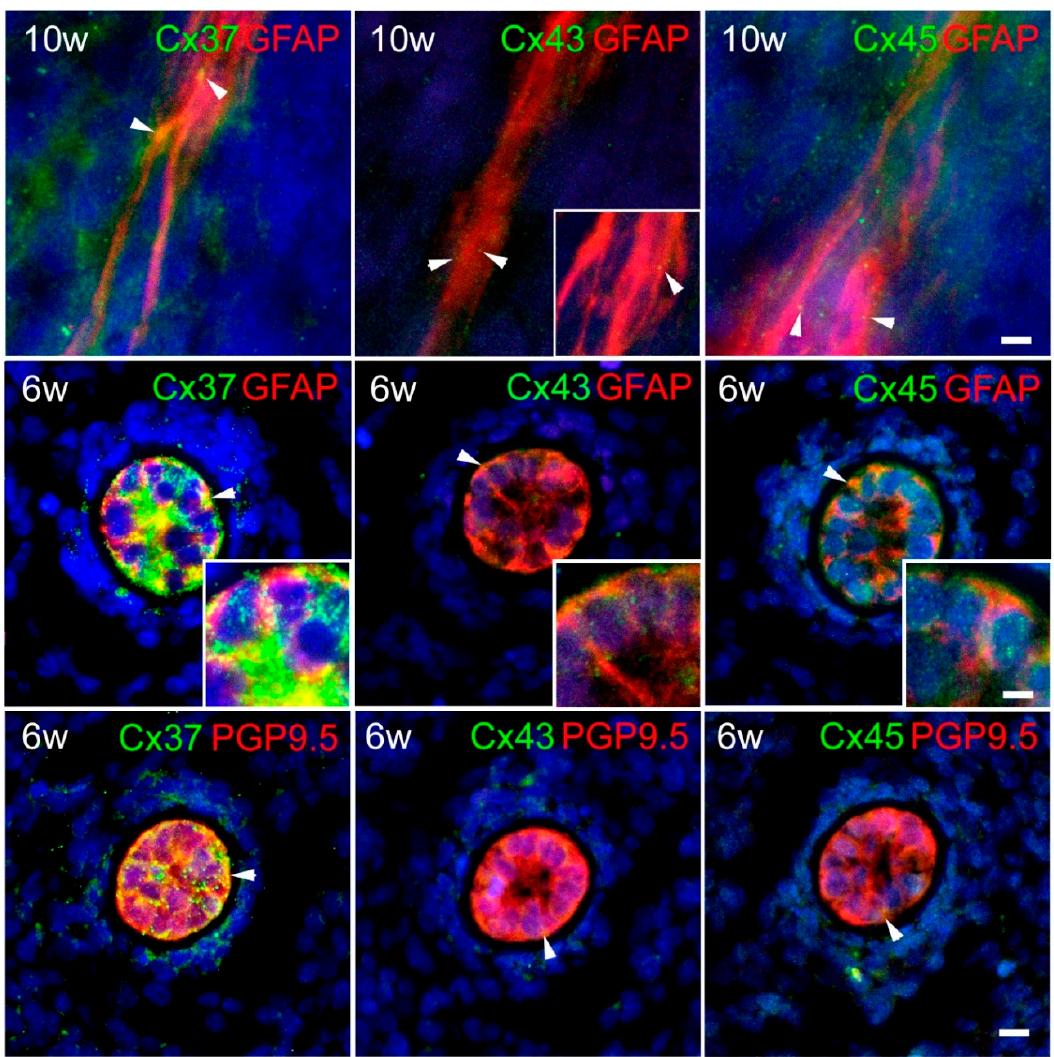
Figure 8. Co-localization of Cxs 37, 43, and 45 and glial fibrillary acidic protein (GFAP) and their expression in the notochord of the human conceptuses. Thoracic segments of the SC of 6 and 10 week-old human conceptuses were stained for Cx37, Cx43, and Cx45 (green), and glial fibrillary acidic protein (GFAP—red) or PGP9.5 (red). Co-localization of all three Cxs with GFAP was found in the roof plate of 10-week-old human fetus (first row). Strong expression of all three—Cx37, Cx43, and Cx45—were found in cells of notochord co-localizing with strong expression of GFAP (second row), as well as with even stronger immunoreactivity of PGP9.5 (third row). Objective magnification—100 × , first row (scale bar = 8 µ m for all); 40 × —main figures on second and third row (scale bar = 20 µ m); insets—100 × (scale bar = 8 µ m). Arrowheads are pointing to the yellow granular pattern of Cx / GFAP or PGP9.5 co-localization in the cytoplasm of the cells of the